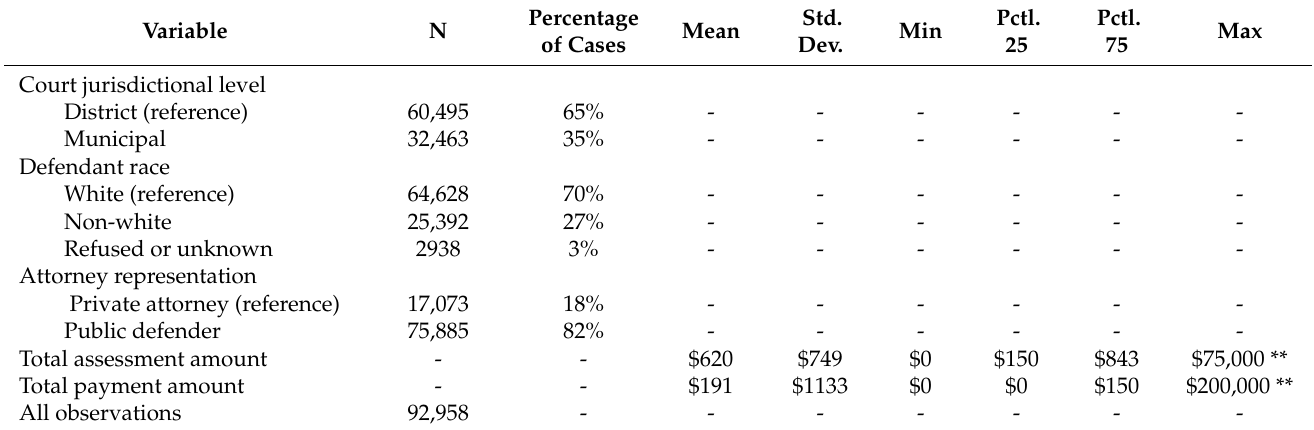
Table 1. Descriptive statistics for non-datetime variables within sample dataset.